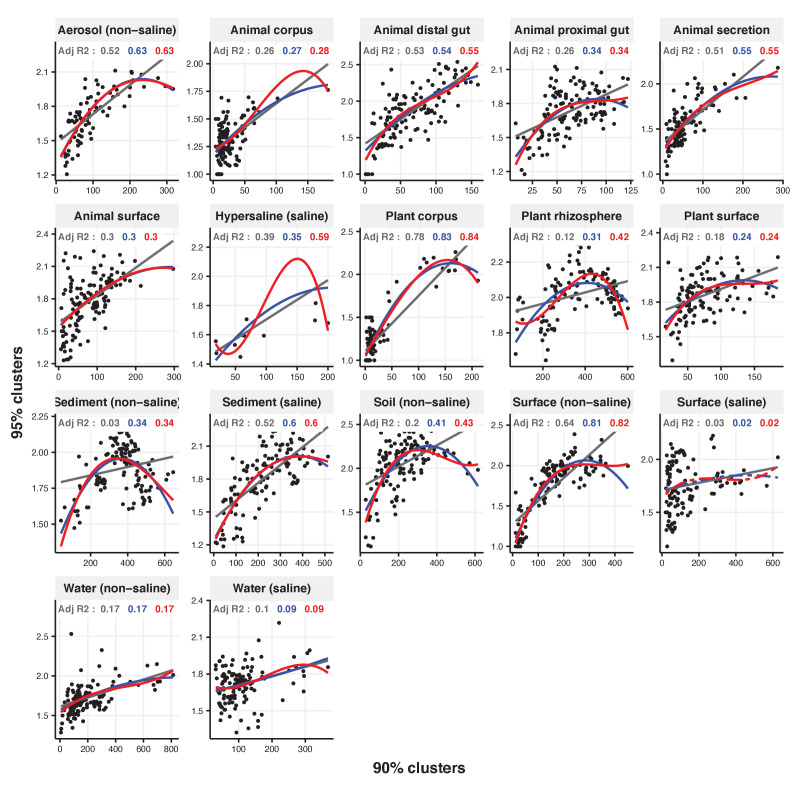
Focal clusters at 90% nucleotide identity.Community diversity was estimated as the number of clusters at a focal level (di) and focal lineage diversity as the mean of the clusters at the rank above (di 1/di). Linear (grey), quadratic (blue) and cubic (red), with corresponding adjusted R-squared values in the same colour. P-values are Bonferroni corrected for 17 tests. Significant, p<0.05 (solid lines), non-significant (dashed lines). The x-axis shows the number of clusters at the focal percent-identity level (di), and the y-axis is the mean of the clusters at the rank above (di 1/di).